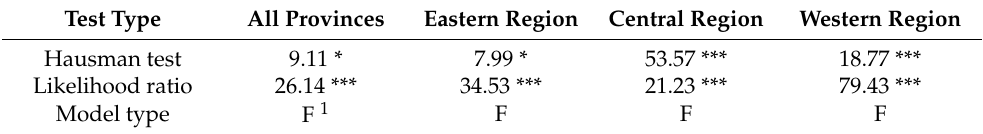
Table 3. Selection results of panel data model (2006–2015).